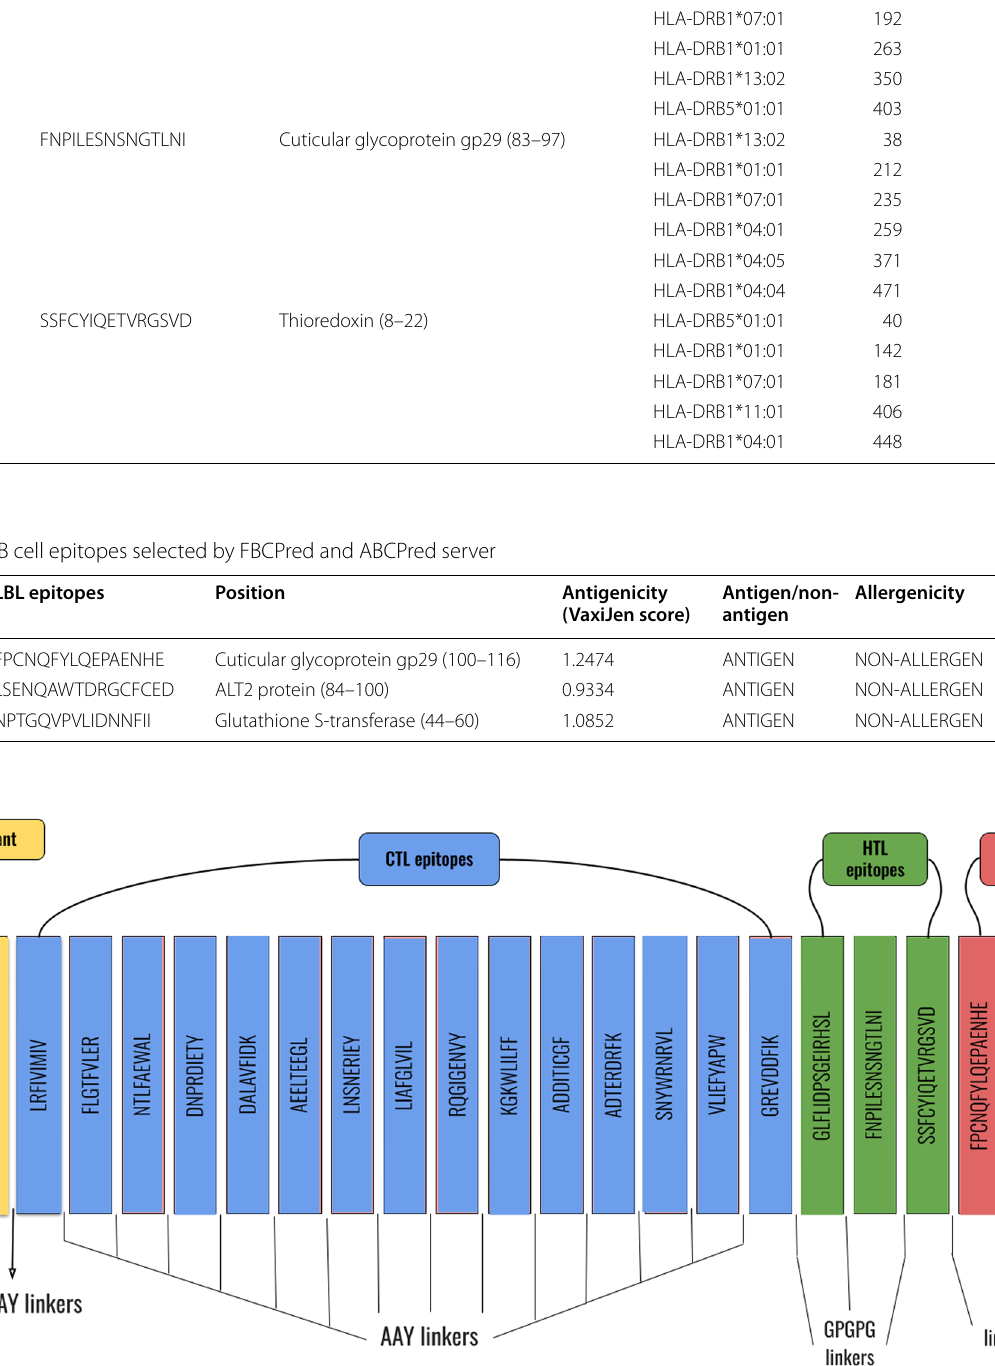
Fig. 2 Diagrammatic representation of the final vaccine